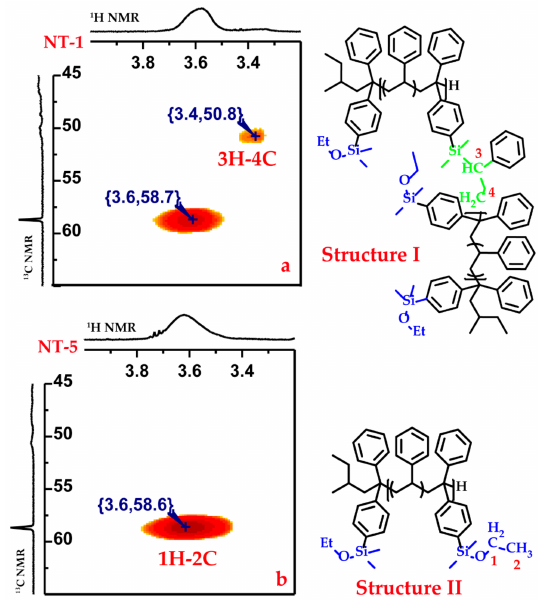
Figure 8. ( a , b ) 1 H- 13 C HMBC 2D NMR spectra of NT-1 and NT-5. Structure ( I ) is probably formed